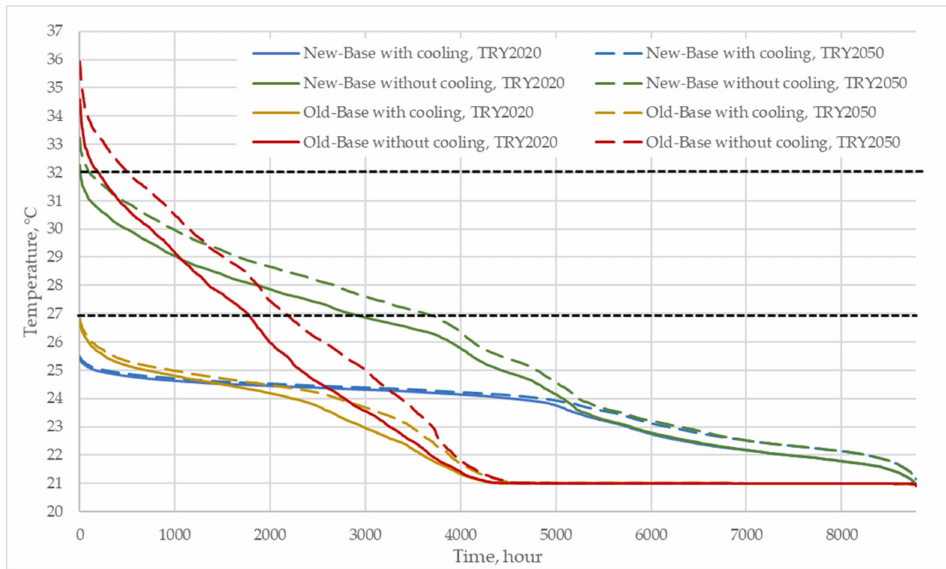
Figure 6. The annual hourly indoor air temperature profile of the warmest bedroom, base cases, new and old building, current and future climate. (The requirements of 27 ◦ C and 32 ◦ C are shown as black dashed